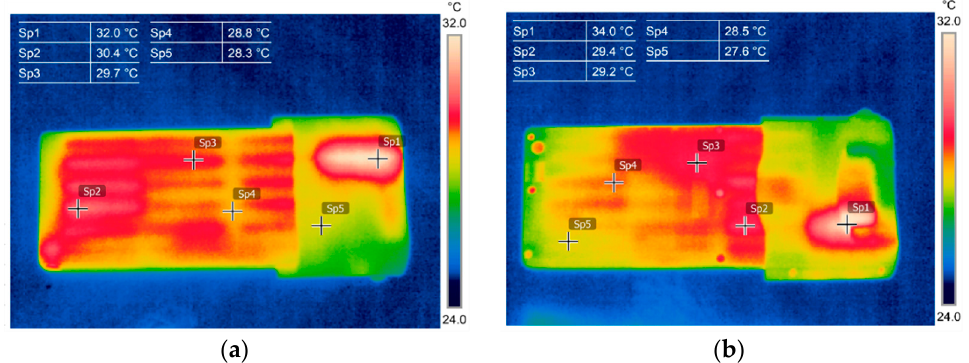
Figure 8. Battery pack assembly thermal pattern, at the end of the lifetime, ( a ) top layer, ( b ) bottom layer. Figure 7. Thermal pattern of the healthy battery pack: inside the bike holder ( a ) and outside ( b ).